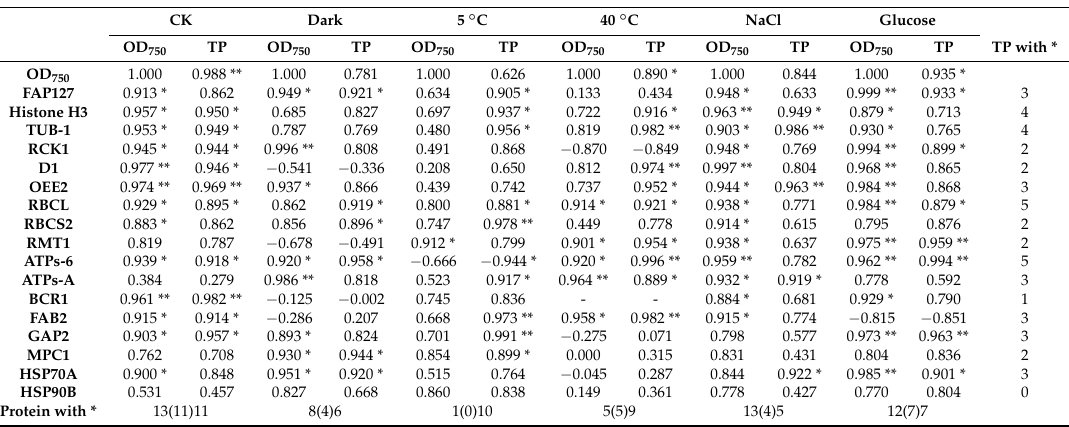
Table 1. Correlation analyses between abundance of candidate proteins and OD 750 /total